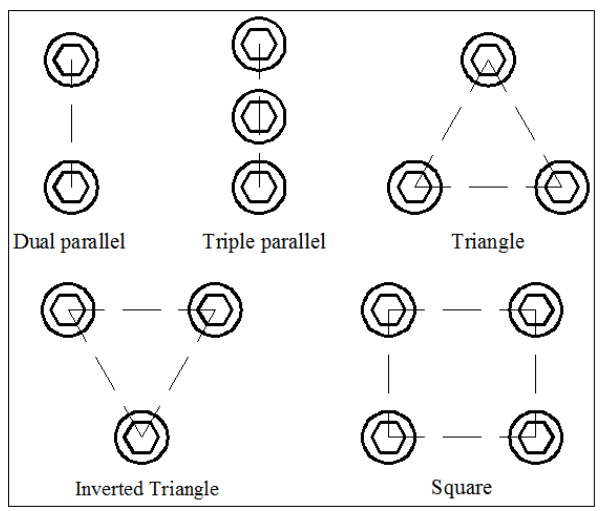
Figure 3. Schematic view of five different configurations for femoral neck